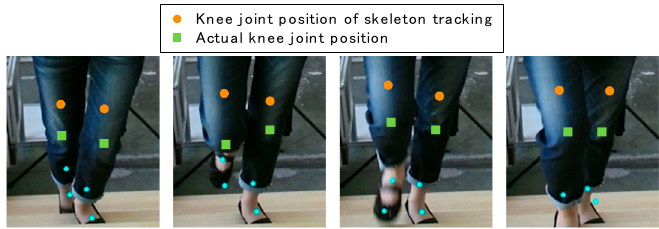
Figure 1. Knee joint position estimation during stair climbing. The knee joint positions detected by the skeleton tracking of Kinect v2 (orange circles) differ significantly from the actual ones (green squares).